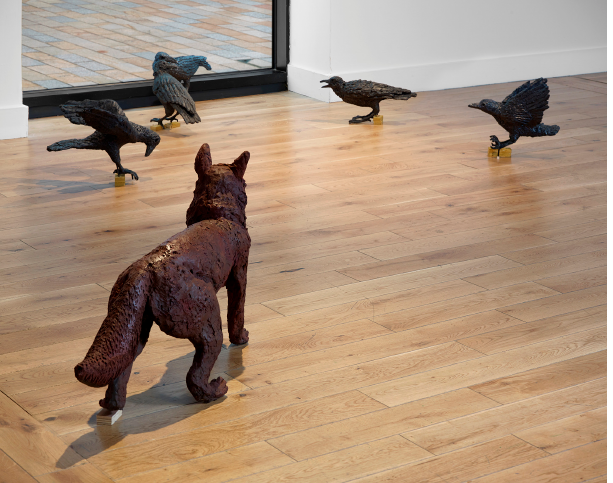
Figure 3. Foxes and crows (2022), Fieldnotes , HOME, Manchester. Ceramic, various sizes. Photograph by Michael Pollard.